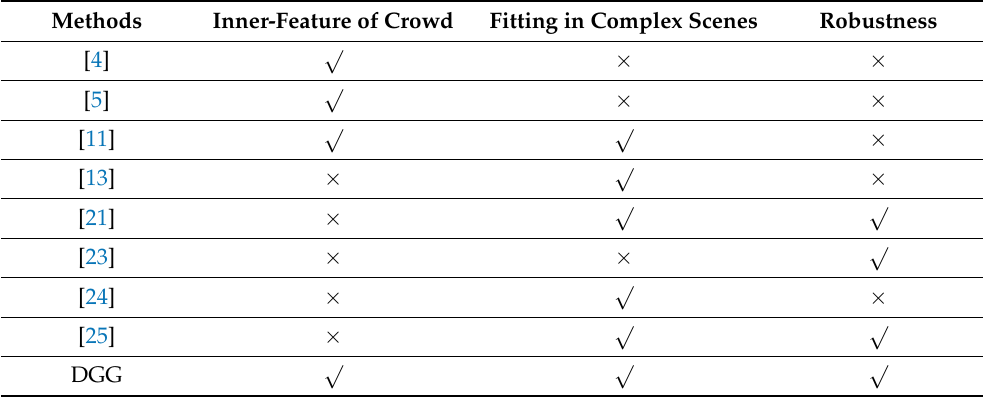
Table 1. The comparative results of different methods in considering the inner feature of crowds, fitting in complex scenes, and the robustness.